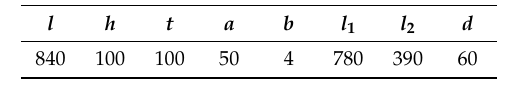
Table 1. Geometric dimensions of specimens (in mm).